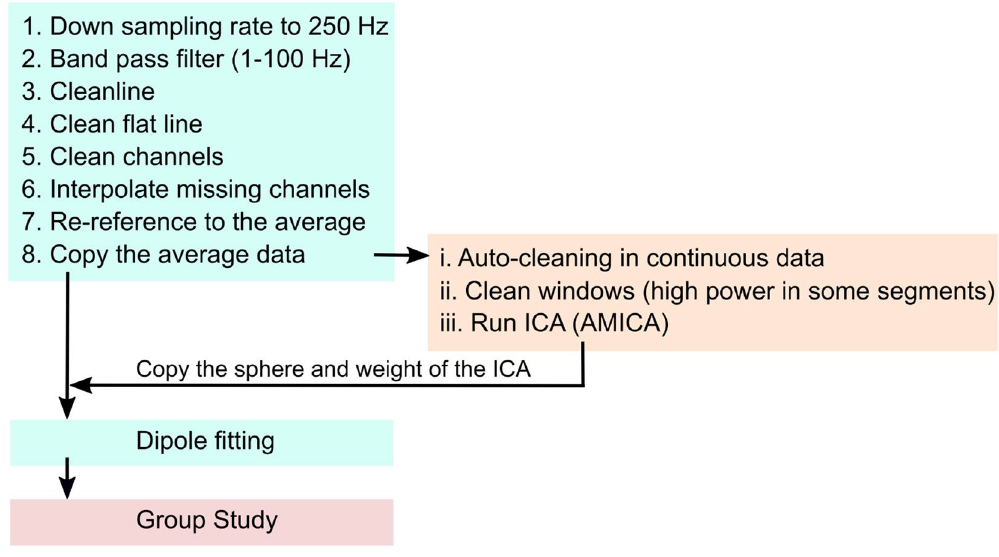
Figure 6. EEG pre-processing